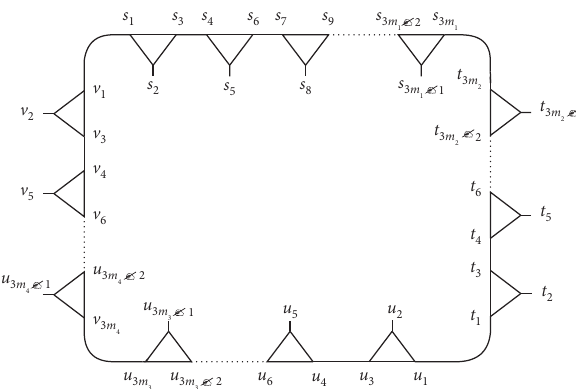
Figure 5: The closed path ( m and m